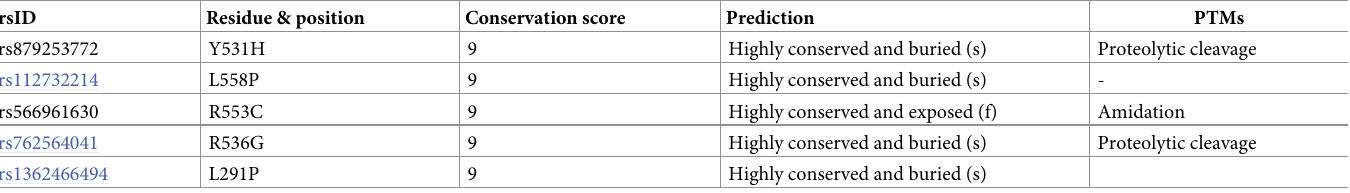
PTMs = Post translational